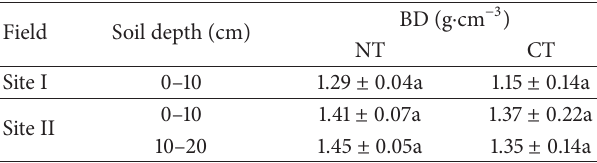
Table 5: Tillage treatments effect on bulk density (mean ± standard